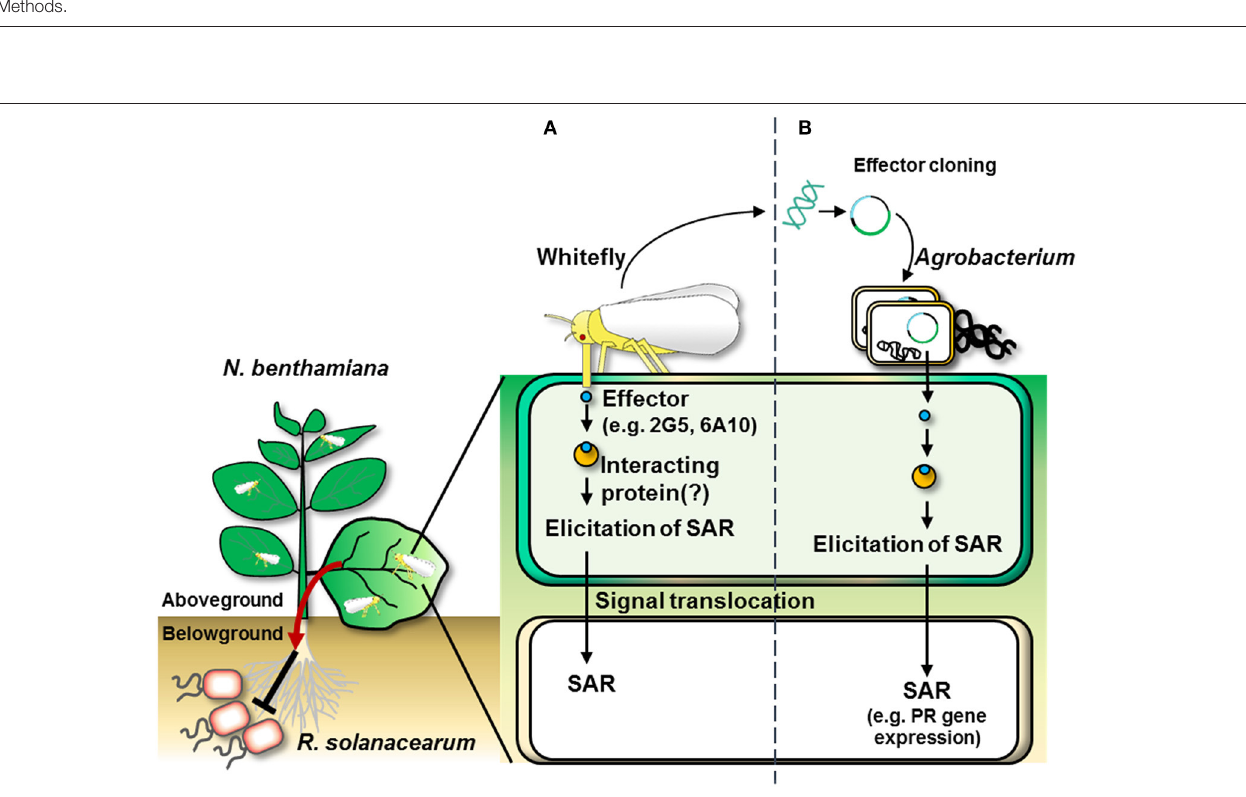
FIGURE 7 | Overall scheme of whitefly effector-induced plant SAR against aboveground and belowground pathogens. (A) The infestation of whitefly on the leaf delivers effectors into the plant. The whitefly effectors might interact with plant partner proteins to induce plant systemic immunity (referred to as “systemic acquired resistance”) as indicated by the transcriptional activation of pathogenesis-related genes (e.g., NbPR1a and NbPR2 ). (B) Whitefly effector cloning. Agrobacterium -mediated transient expression of cDNAs of candidate effectors derived from total RNA from whitefly elicits SAR in N. benthamiana .